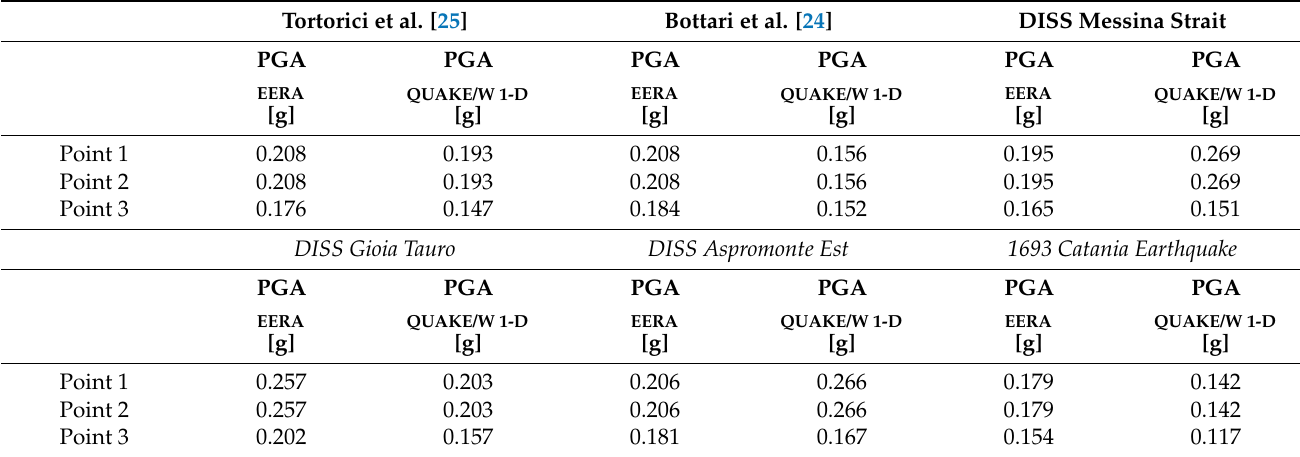
Table 6. PGA by 1-D analyses for the Bottari et al. [24], Tortorici et al. [25], DISS Messina Strait, DISS Gioia Tauro, DISS Aspromonte Est, 1693 Catania earthquake inputs at point 1, 2 and